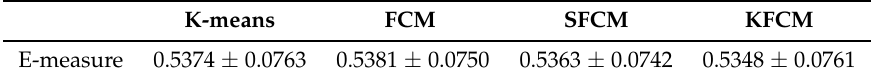
Table 2. Average segmentation results obtained by different clustering algorithms on the test